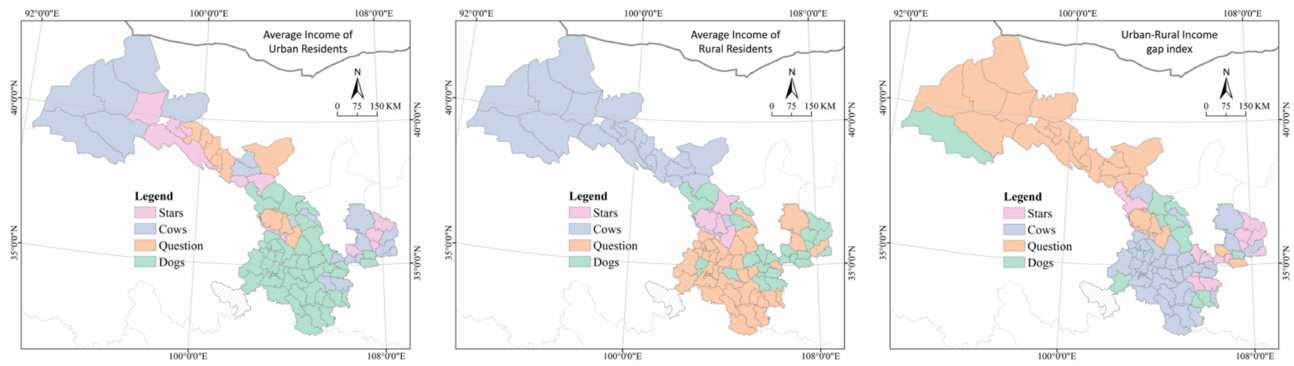
Figure 14. Policy area map of Gansu